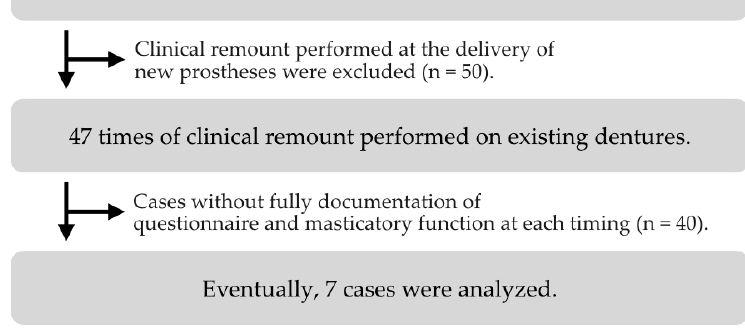
Figure 1. Screening process for data extraction.